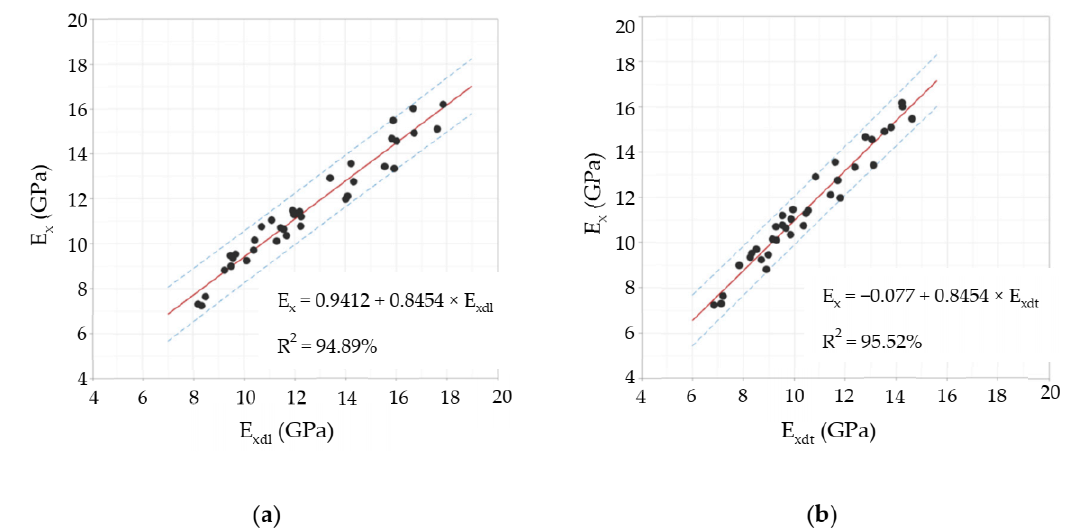
Figure 8. Regression analysis for: ( a ) E x versus E xdl ; ( b ) E x versus E xdt . The red fitted lines show the predicted E x for any E xdl or E xdt value. The blue dashes lines show the 95% prediction